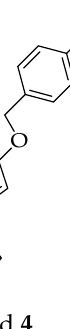
Figure 26. SARs of benzimidazole substituted with thiophene.